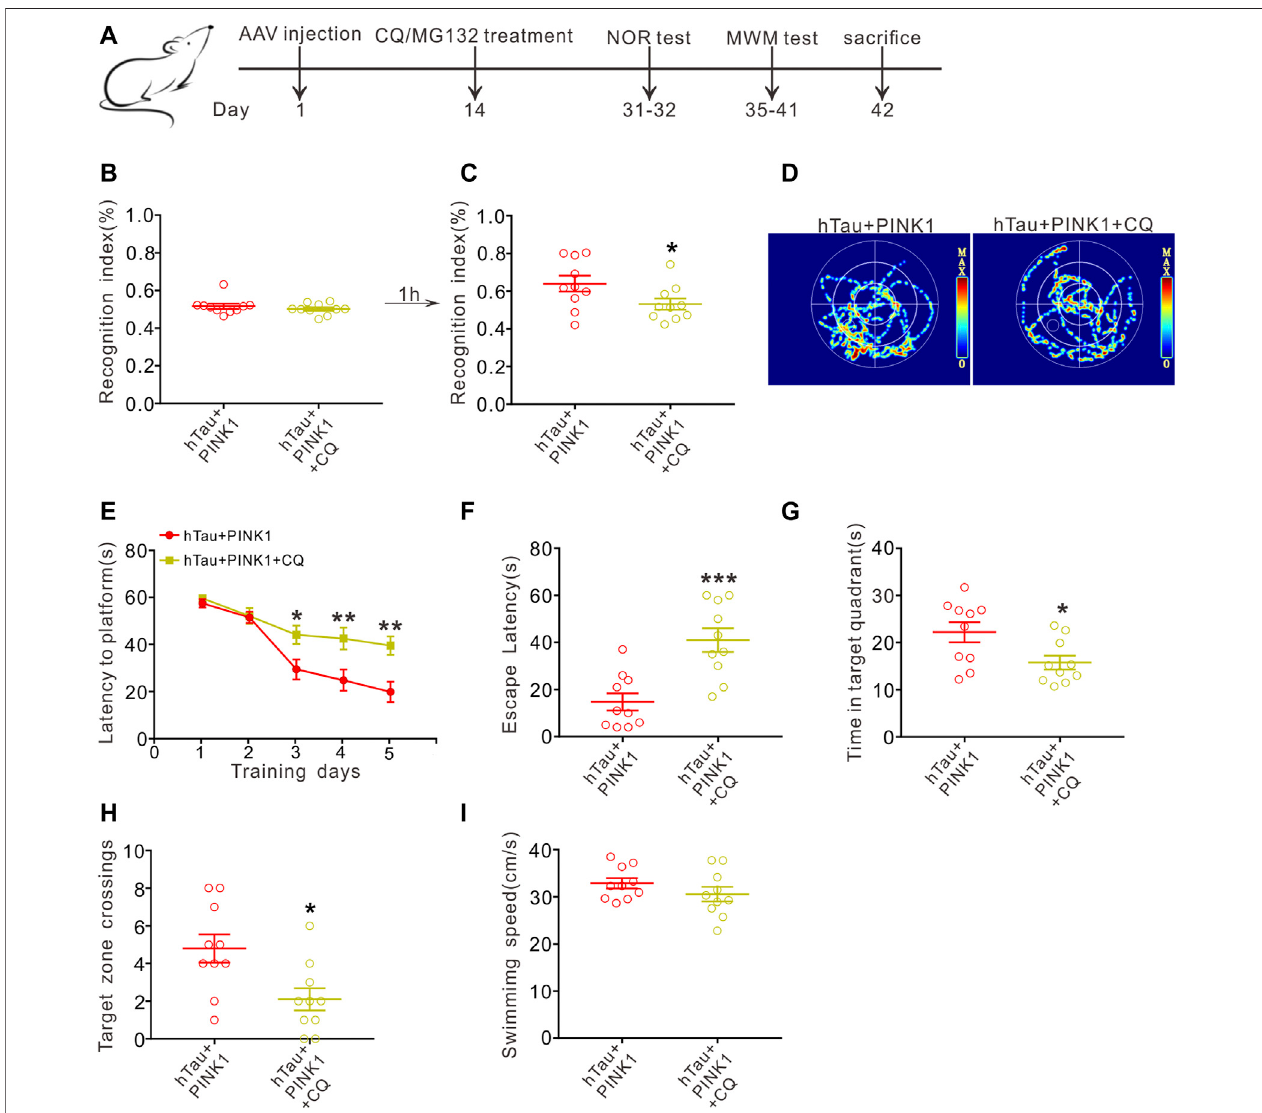
FIGURE 6 | CQ treatment reverses the improved cognition induced by PINK1 overexpression. (A) Experimental processes of virus injection, drug treatment, and behavioral tests. (B,C) CQ treatment lowered the recognition index of hTau and PINK1 overexpressing mice in the NOR test. Unpaired t -tests. * p < 0.05. (D) RepresentativeswimmingpathofmiceineachgroupduringtheMWMprobetest. (E) CQtreatmentimpairedthelearningabilityofhTauandPINK1overexpressingmice, shown by prolonged latency to fi nd the hidden platform during training stage in the MWM test. Two-way repeated-measures ANOVA followed by Tukey multiple- comparisonstests.* p < 0.05,** p < 0.01. (F – H) CQtreatmentimpairedthememoryabilityofhTauandPINK1overexpressingmice,shownbylongerlatencytoreachthe location of platform (F) , shorter retention time in the target quadrant (G) and fewer target zone crossings (H) during the MWM probe test. Unpaired t -tests. * p < 0.05, ** p < 0.01, *** p < 0.001. (I) No signi fi cant difference in swimming speed was seen between the two groups during the MWM probe test. Unpaired t -tests. All data were presented as mean ± SEM. n (cid:2) 10 mice for each